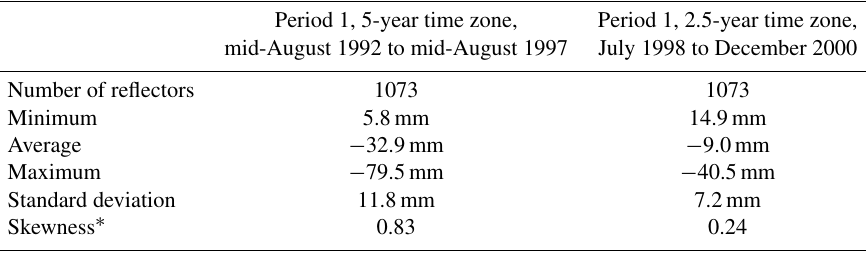
Table 1. Information on total surface movement during the two times zones of 5 and 2.5 years considered in the first observation period for the total area studied.